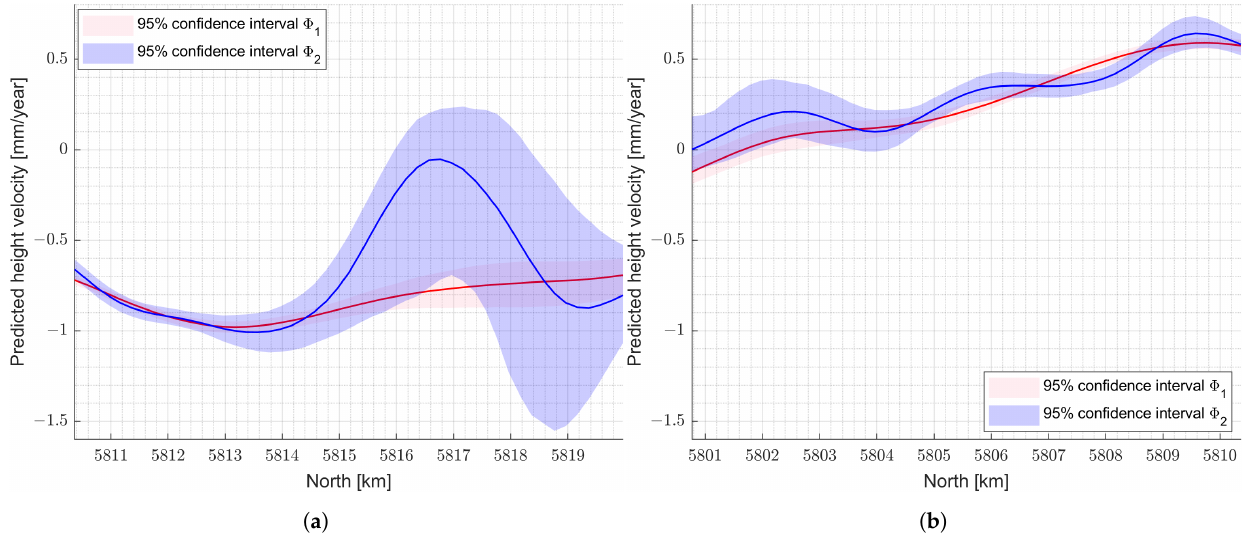
Figure 14. CI from models with different complexities for the two lines in Figure 12. ( a ) Line 1. ( b ) Line